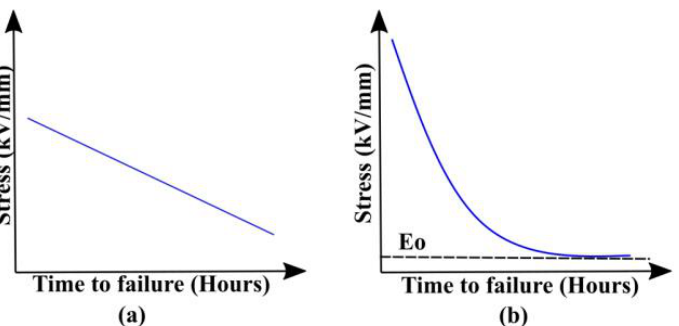
Figure 4. Relationship between applied stress and insulation life for varnished polyamide films using ( a ) inverse life graph; ( b ). exponential life graph adapted with permission from [40]. In many cases, particularly when the diagnostic tests are extended for a long time, the electrical lines show their tendency towards the electrical threshold E O . The life graph of polyethylene terephthalate (PET) film with surface discharge shows an S-shape curve in Figure 5a. The green curve (semi-log plot) follows IPL at first and later tends towards E O at a low value of electrical stress, showing the practical existence of the electrical threshold [42]. The same material was tested in [43] at different temperatures, as shown in Figure 5b. It was observed that the threshold value decreased with increasing temperature; however, its